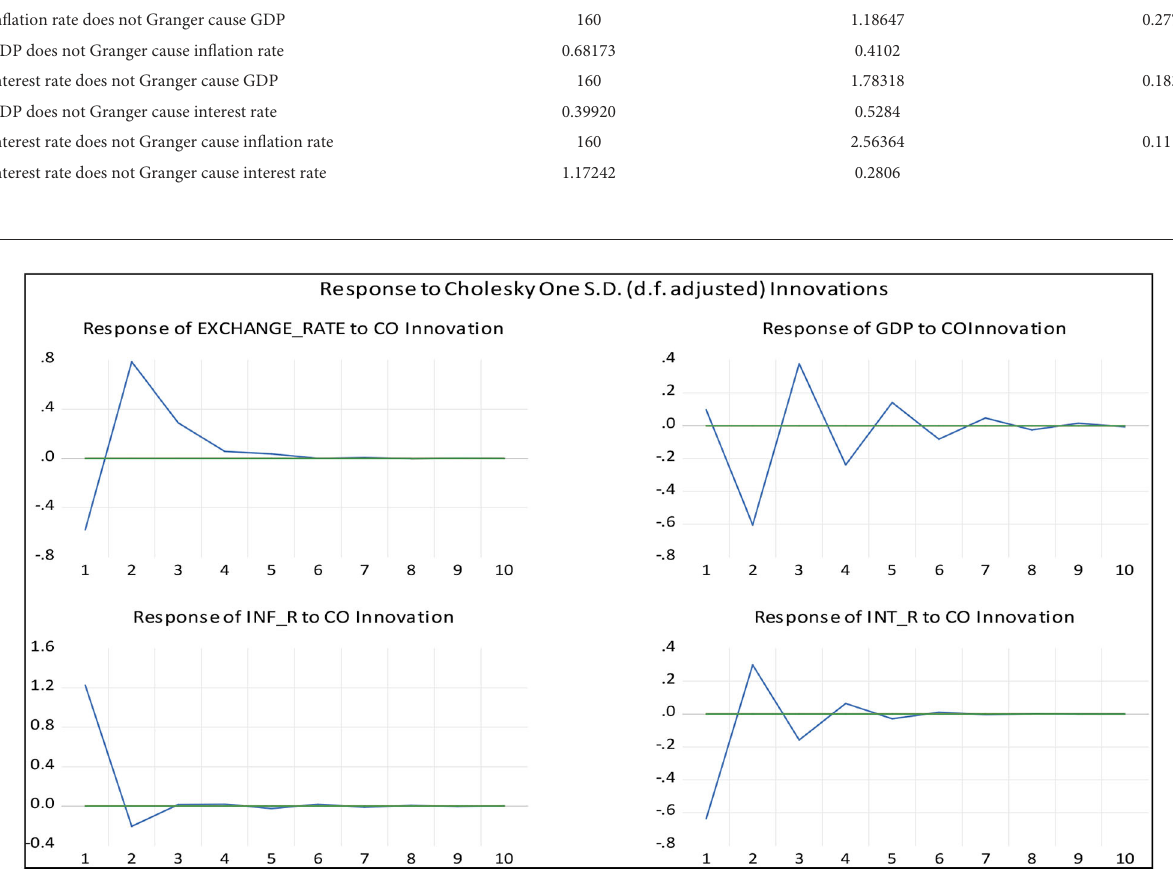
GDP, inflation rate, interest rate, and exchange rate because of crude oil price shocks are 1.02–1.96, 4.22–10.82, 2.98–1.11, 0.31–40.71%, respectively, during the period of the